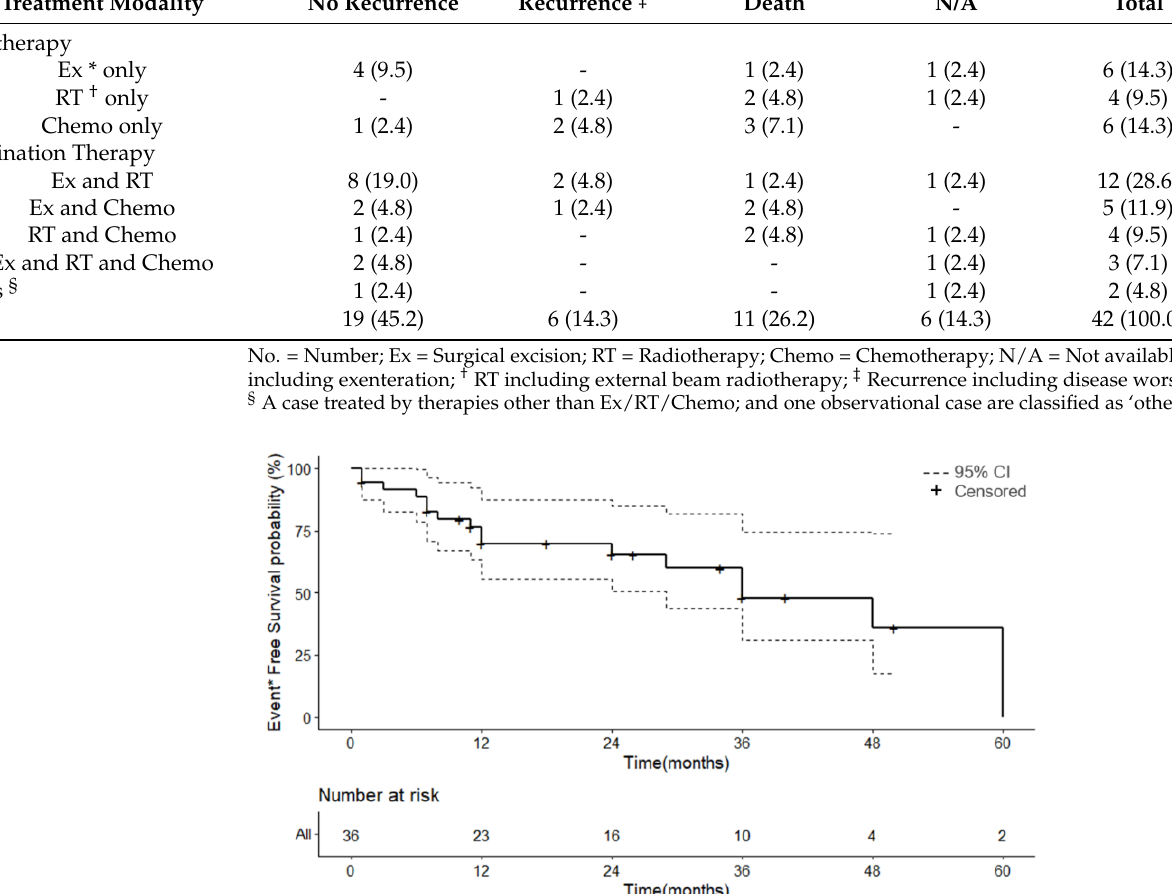
Table 2. Treatment outcomes according to modalities.